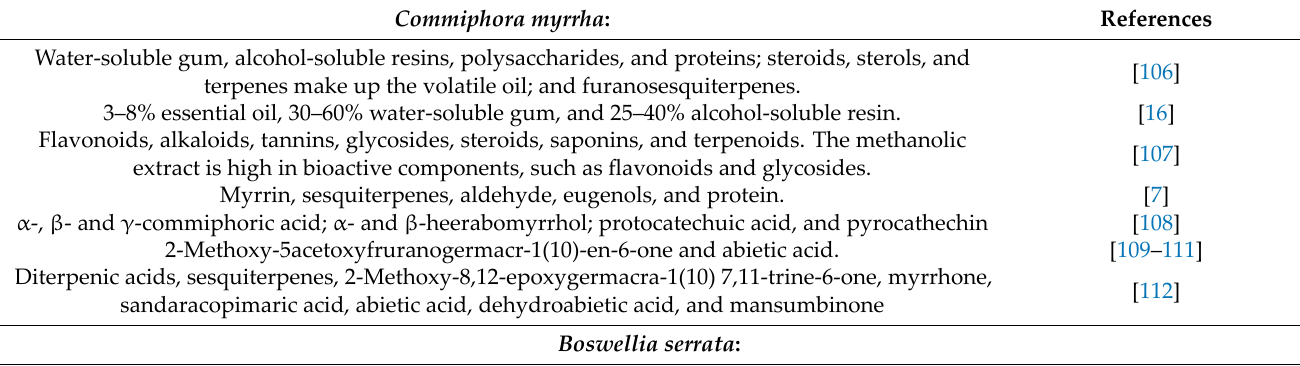
Table 1. Main ingredients and compounds in Commiphora myrrha and Boswellia serrata